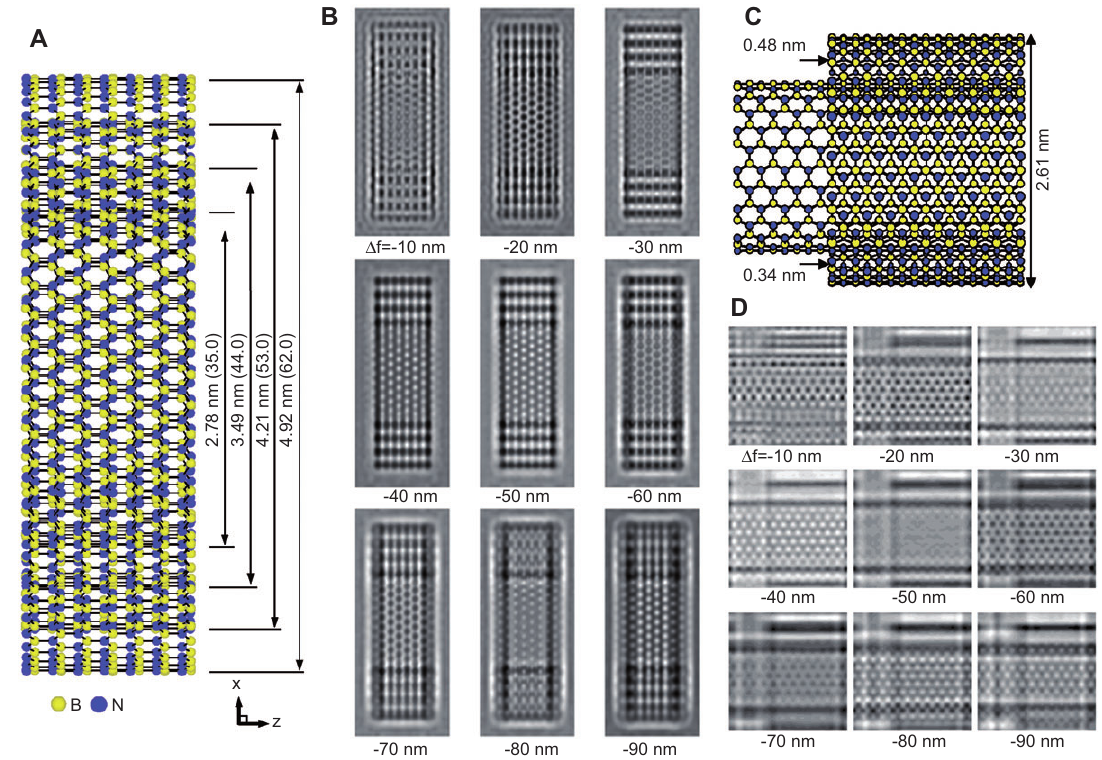
Figure 19 (A) Proposed structure model of quadruple-walled BN nanotube. Chiralities of zigzag BN nanotubes are (35, 0), (44, 0), (53, 0), and (62, 0) from inside to outside. (B) Calculated images of the proposed model (A) as a function of defocus values. (C) Proposed structure model of double-walled BN nanotube. Chiral vectors of nanotube are (13, 13) and (19, 19) for the fi rst and second layers, respectively. (D) Calculated images of the proposed model